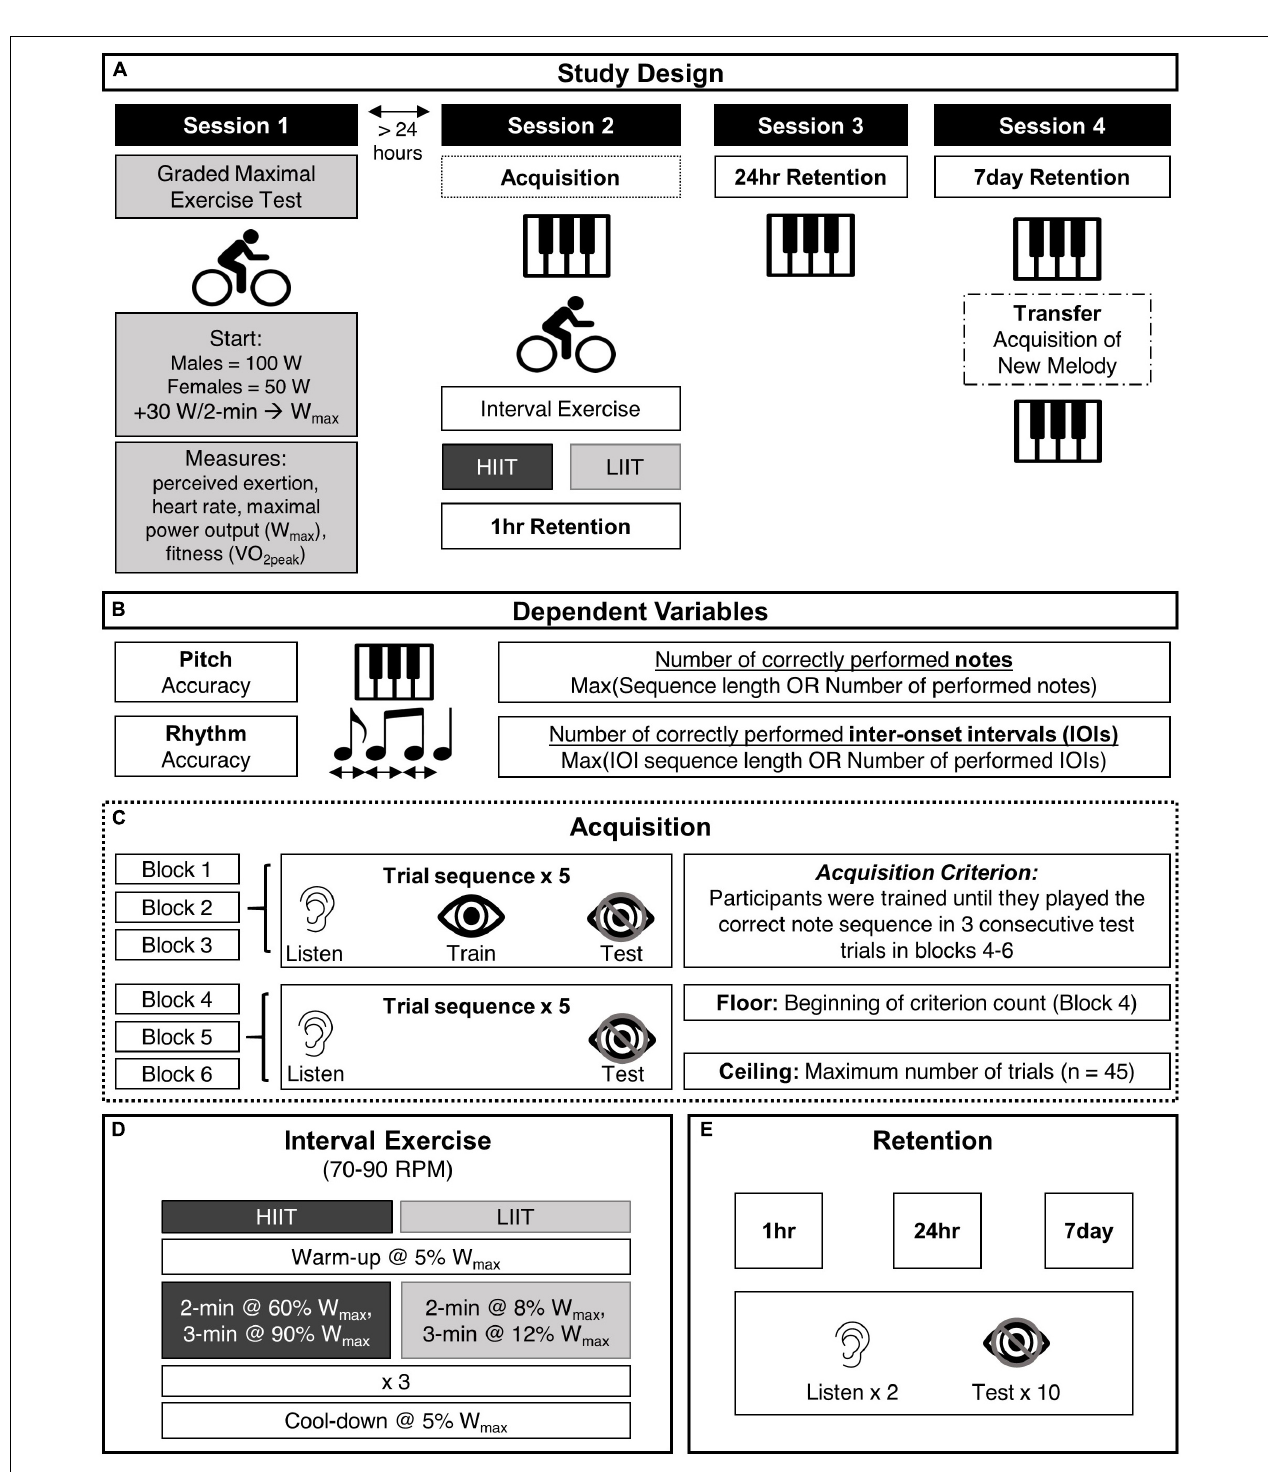
FIGURE 1 | Methods. (A) The study consisted of four sessions (details are in the “Materials and Methods” section): During session 1, participants underwent a graded maximal exercise test. During session 2, participants practiced a melody on a piano keyboard (piano acquisition) and underwent either high- or low-intensity interval training (HIIT or LIIT) on a stationary cycle ergometer (D) . They completed retention tests 1-h (session 2), 24-h (session 3), and 7-days (session 4) after initial training. During session 4, they also practiced a new melody in the transfer task. (B) The dependent variables were pitch and rhythm accuracy. Pitch accuracy was measured as the number of correctly performed notes divided by the longer of either the sequence length or the number of performed notes. Rhythm accuracy was measured as the number of correctly performed inter-onset intervals divided by the longer of either the inter-onset interval sequence length or the number of